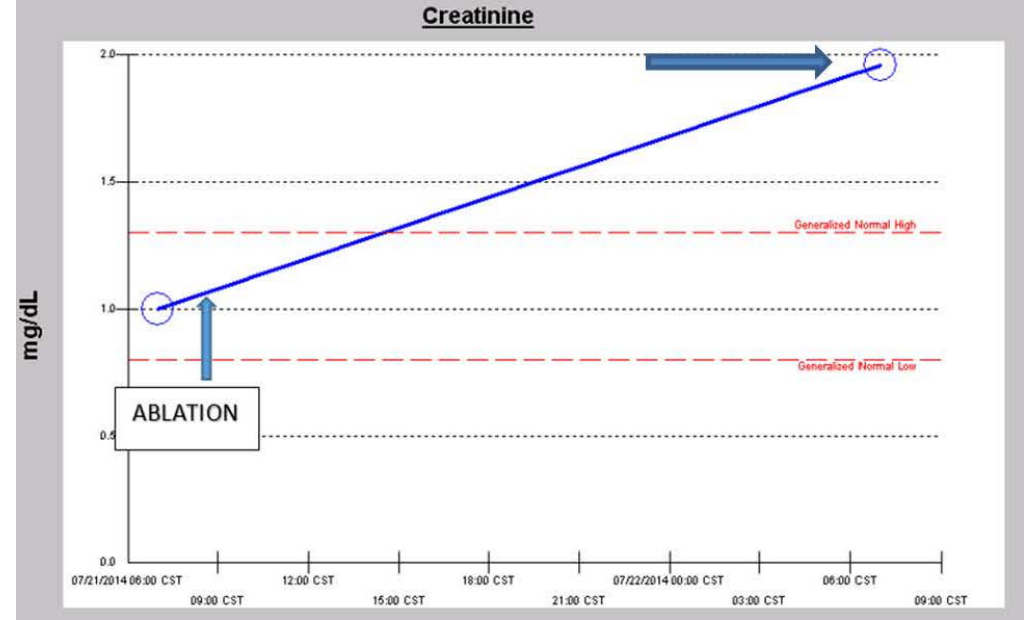
Figure 10. Serum creatinine trajectory on first post-operative day after elective ablation procedure for symptomatic atrial